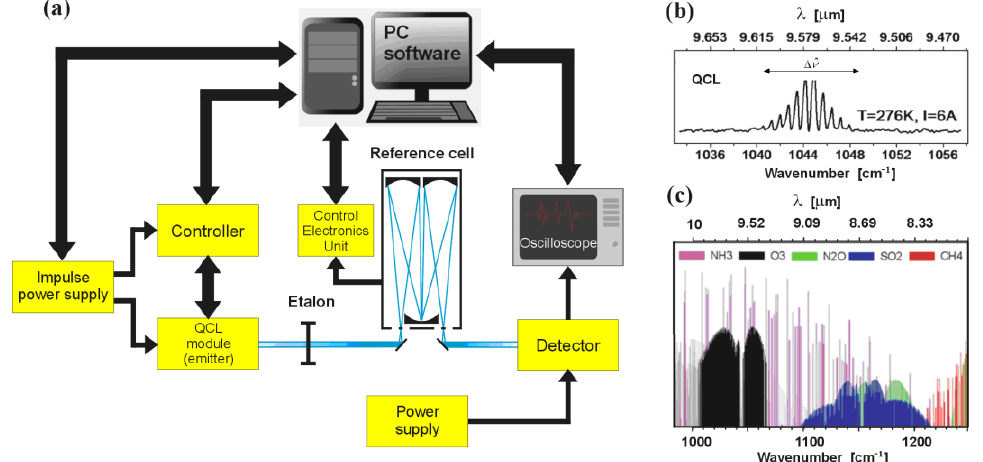
Figure 1. Illustration of the chemical detection method: ( a ) block diagram of a typical detection system with QCL module as emitter; ( b ) energy spectrum of the emitted laser beam for typical power supply conditions; ( c ) absorption spectrum of selected chemical compounds plotted on the basis of HITRAN.